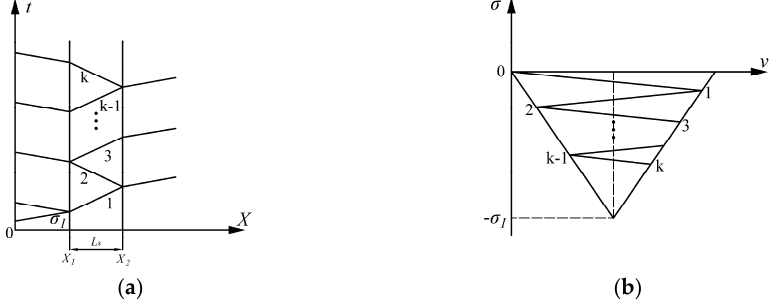
Figure 2. The process propagation of stress waves in the specimen, ( a ) is the X-t diagram, showing the process of stress wave propagation between bars and the specimen; and ( b ) is the σ -v diagram, showing the value of stress in the specimen changing with k.